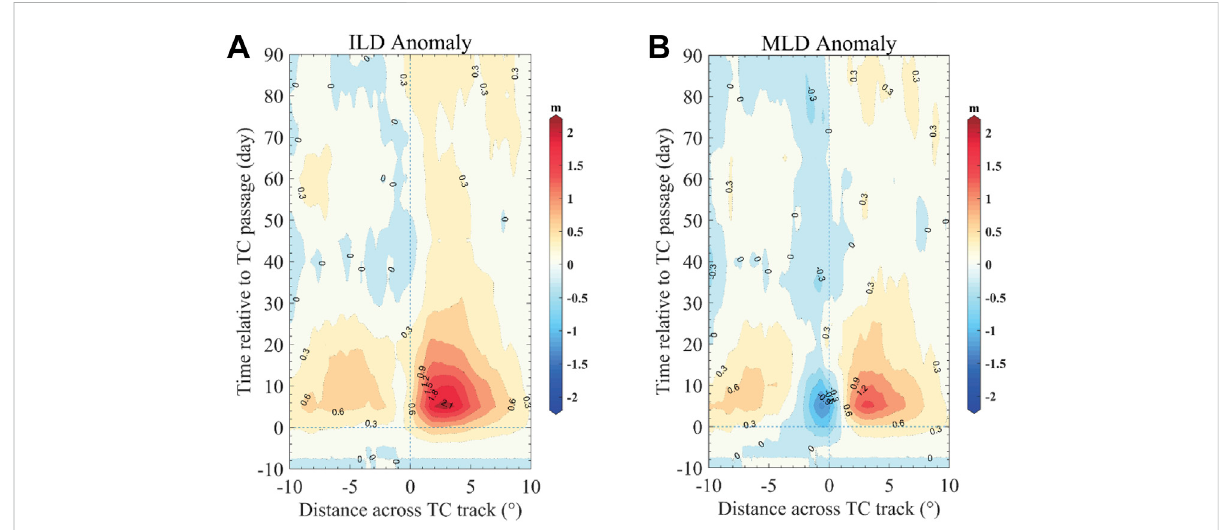
Temporal evolution of the along-track-averaged composite (A) isothermal layer depth (m) and (B) mixed layer depth (m). The climatological trend has been removed from the anomalies of isothermal layer depth and mixed layer depth.